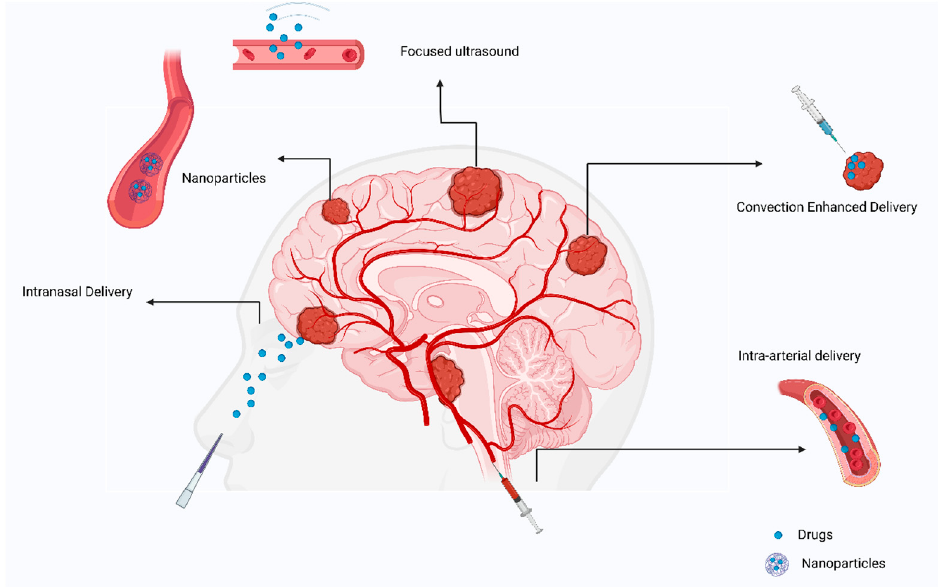
Figure 4. Review of current approaches to treating primary brain tumors.